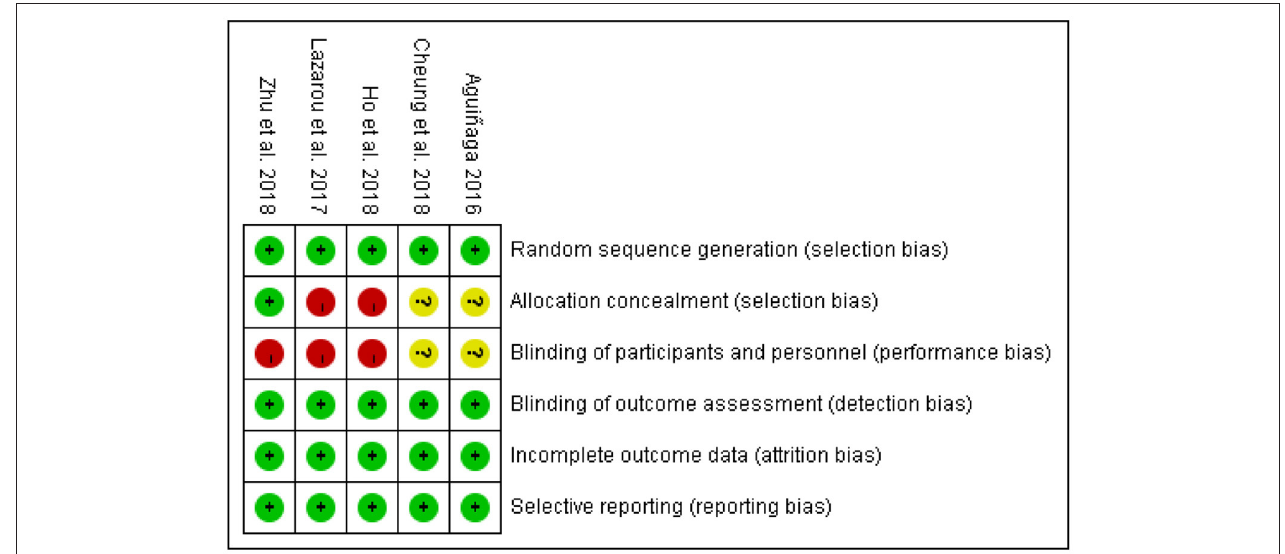
FIGURE 2 | Risk of bias summary. *Green represents low risk; Red represents high risk; Yellow represents unclear.